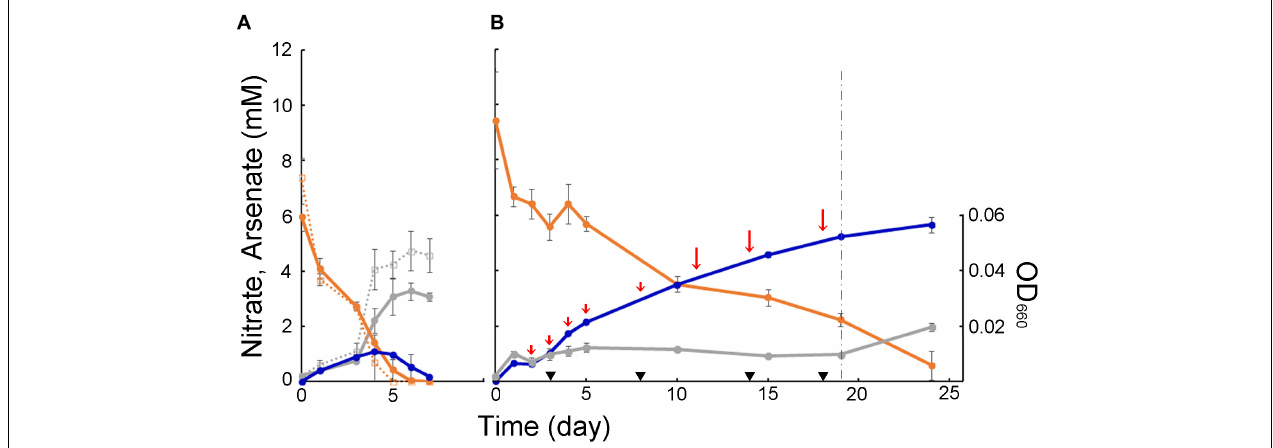
FIGURE 3 | Anaerobic growth of strain M52 assessed as optical density at 660 nm (gray), and changes in concentrations of nitrate (orange) and arsenate (blue). Bars represent standard deviation from triplicates. (A) Experiments in medium containing acetate. Dashed lines represent culture without arsenite. (B) Experiments in medium without acetate. Short and long red arrows indicate time points of addition of arsenite, 0.5 and 1 mM, respectively. Black triangles and dashed green line indicate time points of addition of bicarbonate (0.65 mM) and acetate (5 mM),